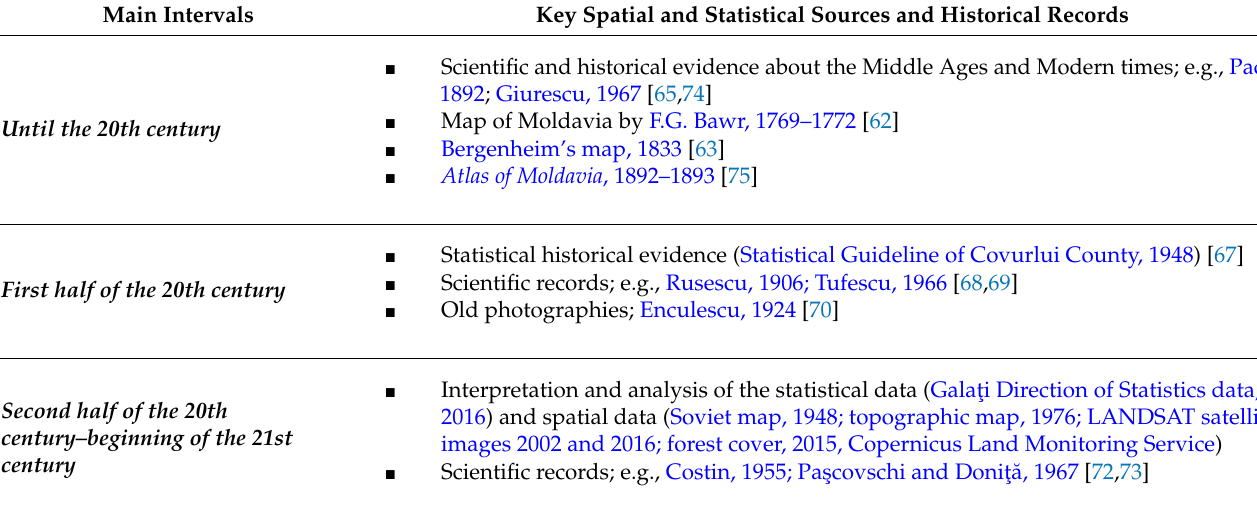
Table 1. Statistical and spatial data sources